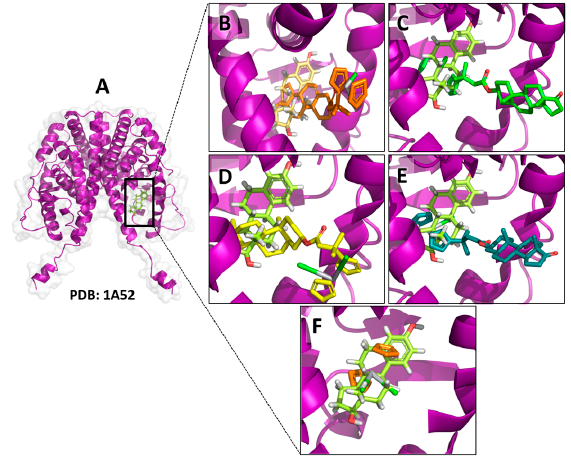
Figure 4. 3D-view ER α -LBD- β -estradiol (native ligand) complex ( A ); ER α -LBD- β -estradiol with Ti-pregnenolone ( B ); Ti-dehydroepiandrosterone ( C ); Ti-androsterone ( D ); Ti- trans -androsterone ( E ); and titanocene dichloride ( F ) on binding site.